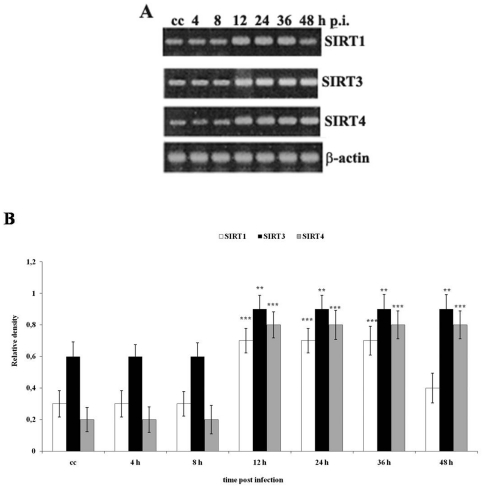
Expression of SIRT1, SIRT3 and SIRT4 cDNA of mock-infected and infected cells at the indicated times at different post infection.(A) The RT-PCR products were examined by 1.6% agarose gel electrophoresis. (B) Densitometric analysis of the corresponding band to SIRT1, SIRT3 and SIRT4. The bars represent the mean ± SEM of the results from three separate experiments. Significant differences between CCoV-II-infected cells and control cells are indicated by probability P. **P <0.01 and ***P <0.001.